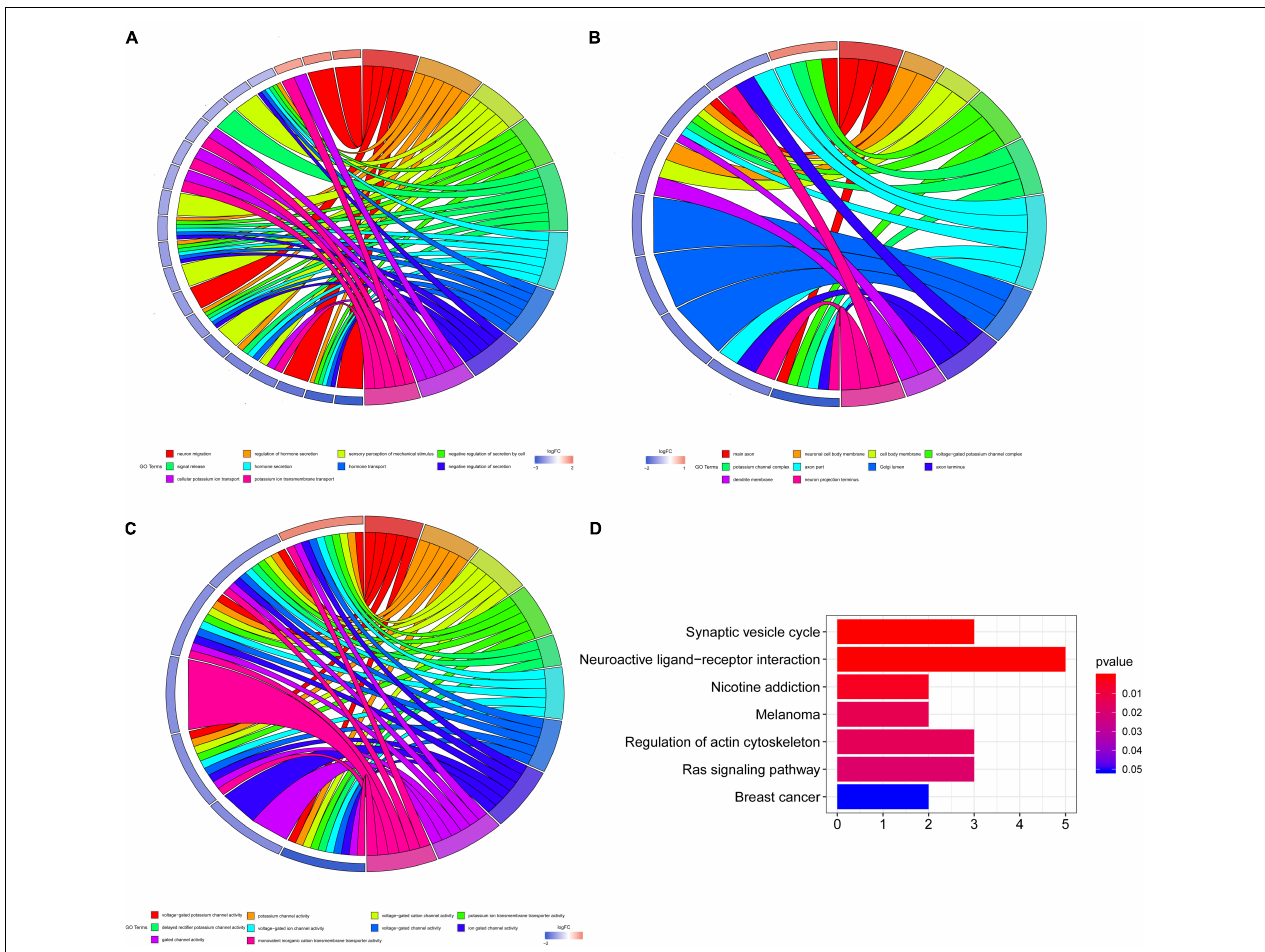
FIGURE 2 | Enrichment analysis of Gene Ontology (GO) and Kyoto Encyclopedia of Genes and Genomes (KEGG). (A) The top 10 most enriched biological process (BP) entries. The right half circle is the 10 enriched BP terms, which are represented by different colors; the left half circle is the enriched mRNA in these 10 terms, red represents the upregulated mRNA, and blue represents the downregulated mRNA. (B) The primary 10 cellular component (CC) entries that are most significantly enriched. (C) The top 10 molecular function (MF) entries that are most significantly enriched.